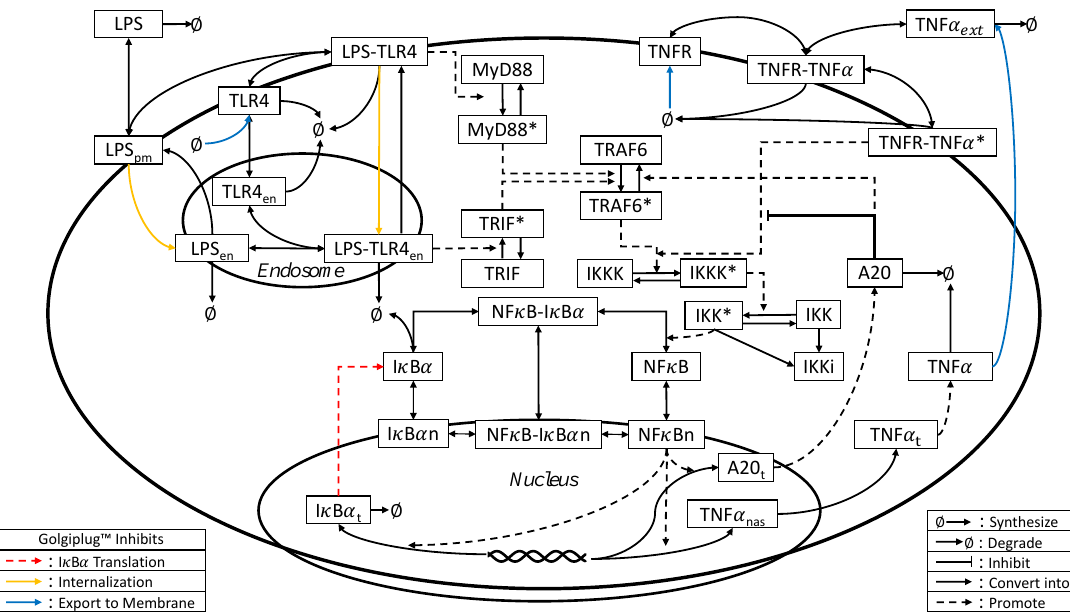
Figure 1. Schematic diagram for the LPS-NF κ B-TNF α signaling pathway. Due to space limitation, TRIF-dependent regulation of TNF α production, I κ B β and I κ B (cid:101) -dependent NF κ B deactivation and eIF2 α -induced translation inhibition are not illustrated. Furthermore, some states related to TNF α -induced activation of IKK kinase (IKKK) are not shown. Colored arrows indicate the processes affected by the addition of Golgiplug ™ (see the text for